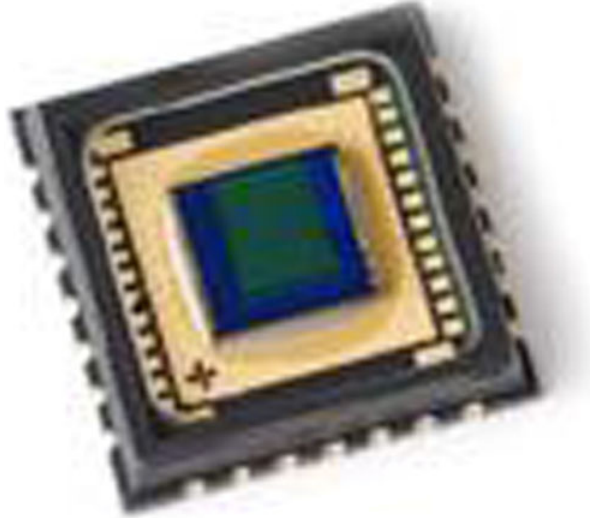
Figure 3 A CMOS image sensor (picture adopted from Web site http://www.ovt.com; OmniVision Technologies, Inc n.d.).